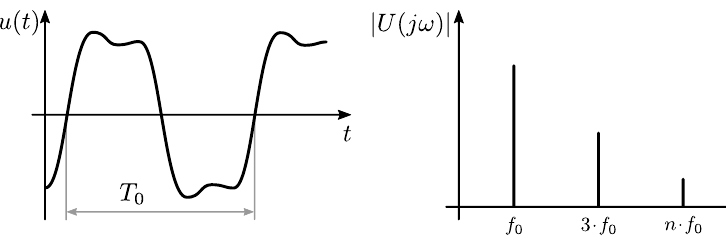
Figure 2. Ferroresonance characteristics for fundamental oscillations.